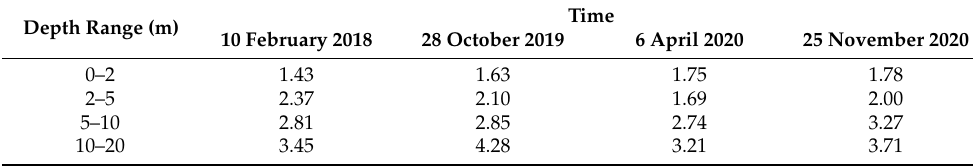
Table 5. RMSEs of different water depth ranges. Units: